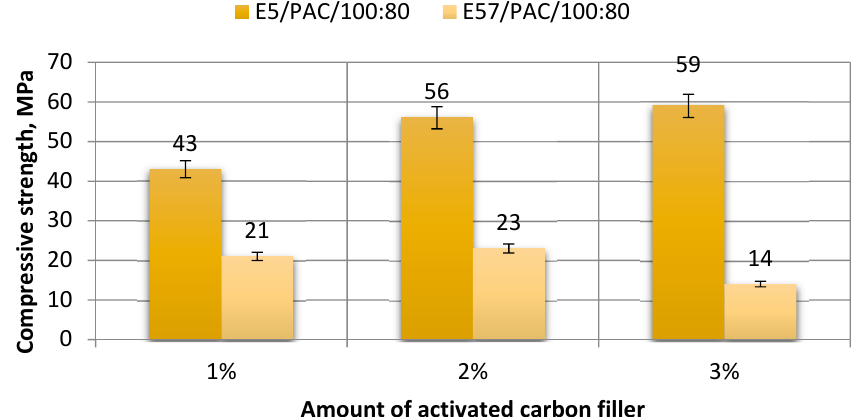
Figure 24. Comparison of the compressive strength between the E5/PAC/100:80 and E57/PAC/100:80 epoxy specimens modified by the activated carbon filler post-thermal shock chamber aging.